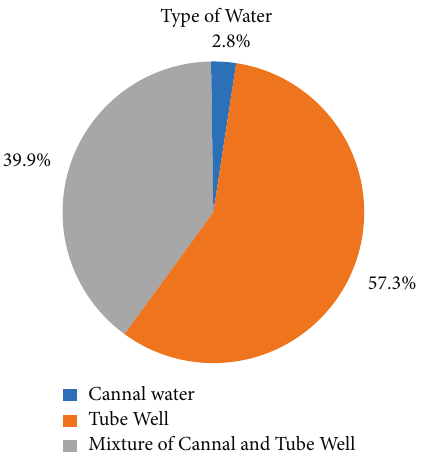
Figure 1: Pie chart for previously sown crops.